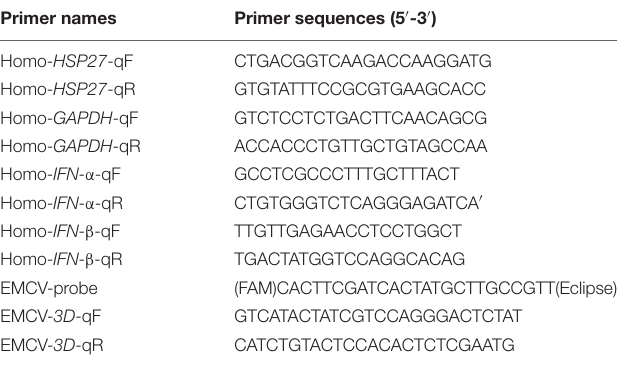
TABLE 2 | Nucleotide sequences of the RT-qPCR primers.